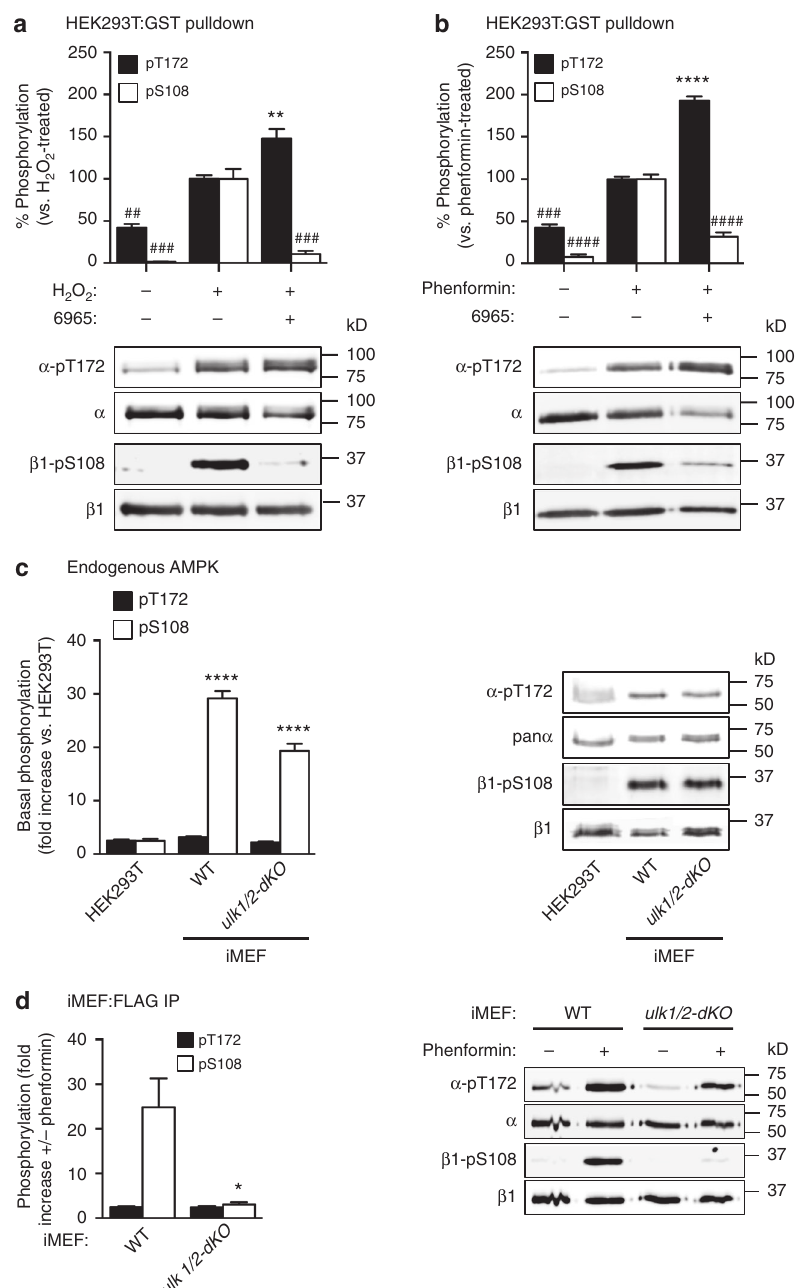
Fig. 6 ULK phosphorylates β 1-Ser108 in cells. Statistical analyses were performed using one-way ANOVA with post hoc Dunnett ’ s multiple comparison test, unless indicated. Immunoblots for β 1-pSer108 and α -pThr172 in KI- α 1 β 1 γ 1 puri fi ed from HEK293T cells incubated with a 1 mM H 2 O 2 and 10 μ M 6965 for 45 min, or b 2 mM phenformin and 10 μ M 6965 for 1 h. n = 3, representative immunoblots shown. Error bars , mean % phosphorylation relative to H 2 O 2 - or phenformin-treated ± s.e.m. ** P < 0.01 indicates signi fi cant increase, and ## P < 0.01, ### P < 0.001 and #### P < 0.0001 indicate signi fi cant decrease, compared to H 2 O 2 - or phenformin-treated. c Immunoblots for β 1-pSer108 and α -pThr172 in lysates from HEK293T cells, WT or ulk1/2-dKO iMEFs incubated in 25 mM glucose DMEM + 10% serum. n = 3 individual cultures per cell line, representative immunoblots shown. Error bars , mean fold increase in phosphorylation relative to HEK293T cells ± s.e.m. **** P < 0.0001 indicates signi fi cant increase in phosphorylation compared to HEK293T cells. d Immunoblots for β 1-pSer108 and α -pThr172 in KI- α 1 AMPK puri fi ed from WT or ulk1/2-dKO iMEFs stimulated with 2 mM phenformin for 1 h. n = 3, representative immunoblots shown. Error bars , mean fold increase in phosphorylation relative to basal ± s.e.m. Statistical analysis was performed using unpaired two-tailed Student ’ s t -test. * P < 0.05 indicates signi fi cant decrease compared to WT